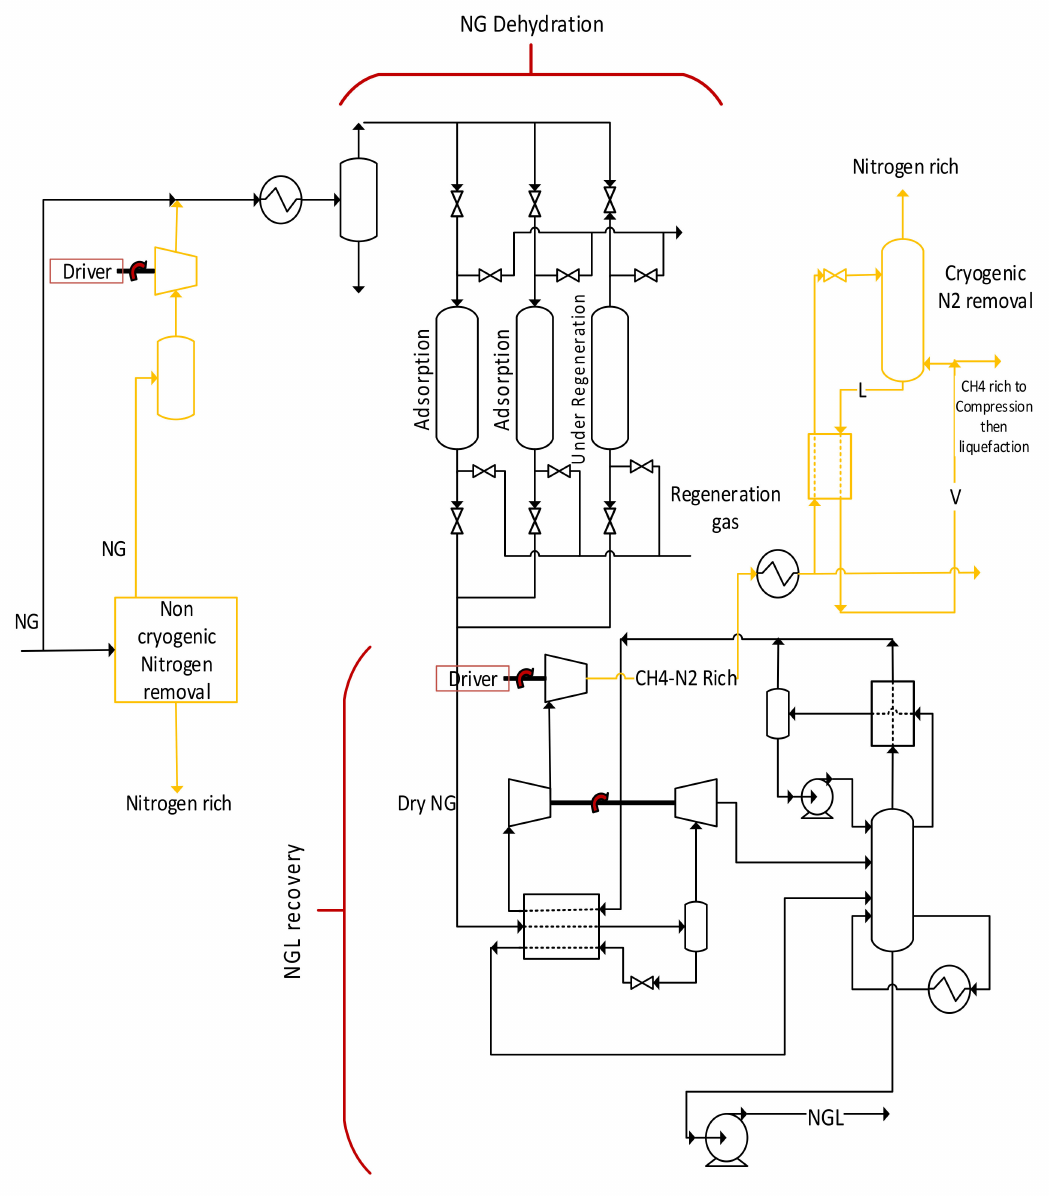
Figure 2. Hybrid upfront N 2 removal making use of cryogenic and non-cryogenic processes. The orange lines represent upfront N 2 removal before dehydration and